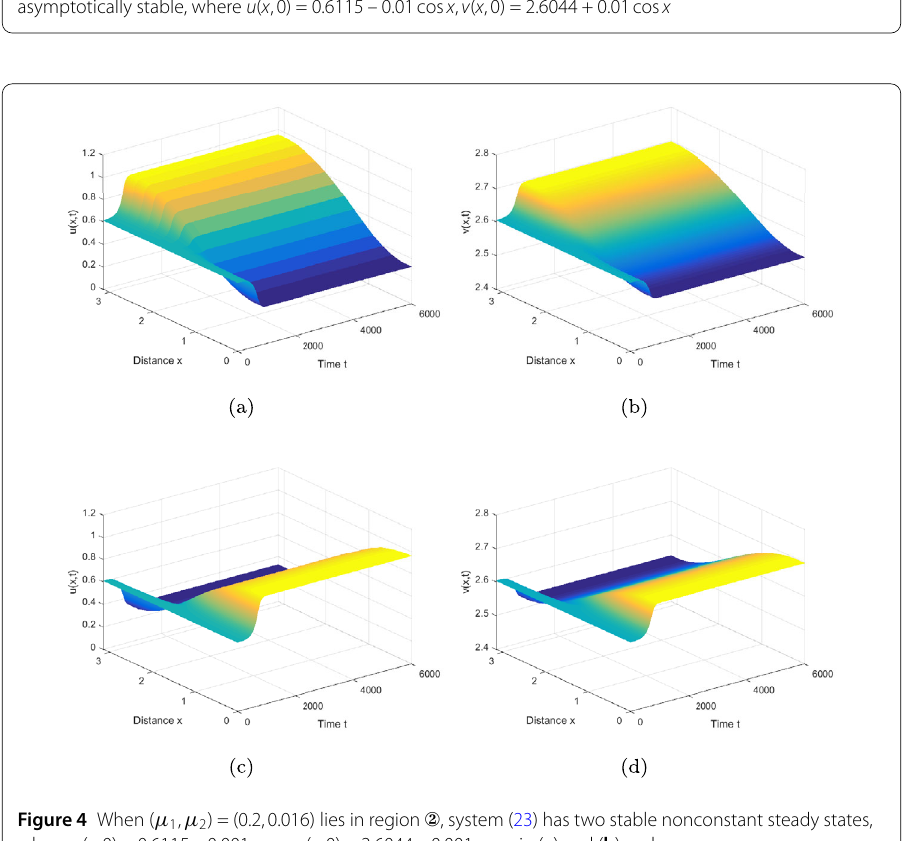
Figure 4 When ( μ 1 , μ 2 ) = (0.2,0.016) lies in region ② , system (23) has two stable nonconstant steady states, where u ( x ,0) = 0.6115 – 0.001cos x , v ( x ,0) = 2.6044 – 0.001cos x in ( a ) and ( b )